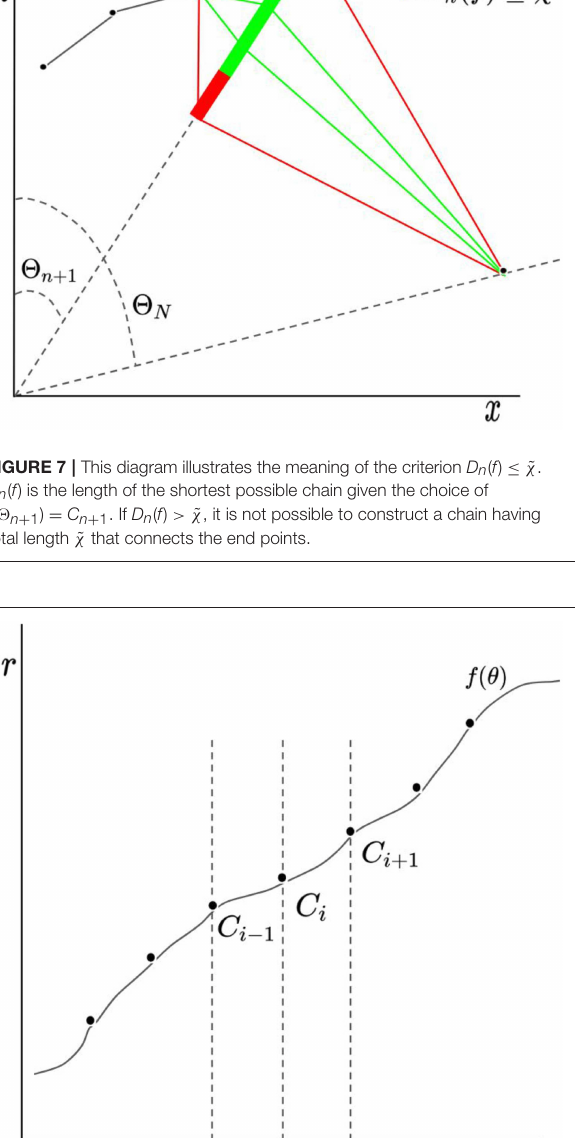
FIGURE 6 | This diagram illustrates the meaning of the function L f ( a , b ) given a curve r = f ( θ ) which passes through points at θ = a and θ = b .